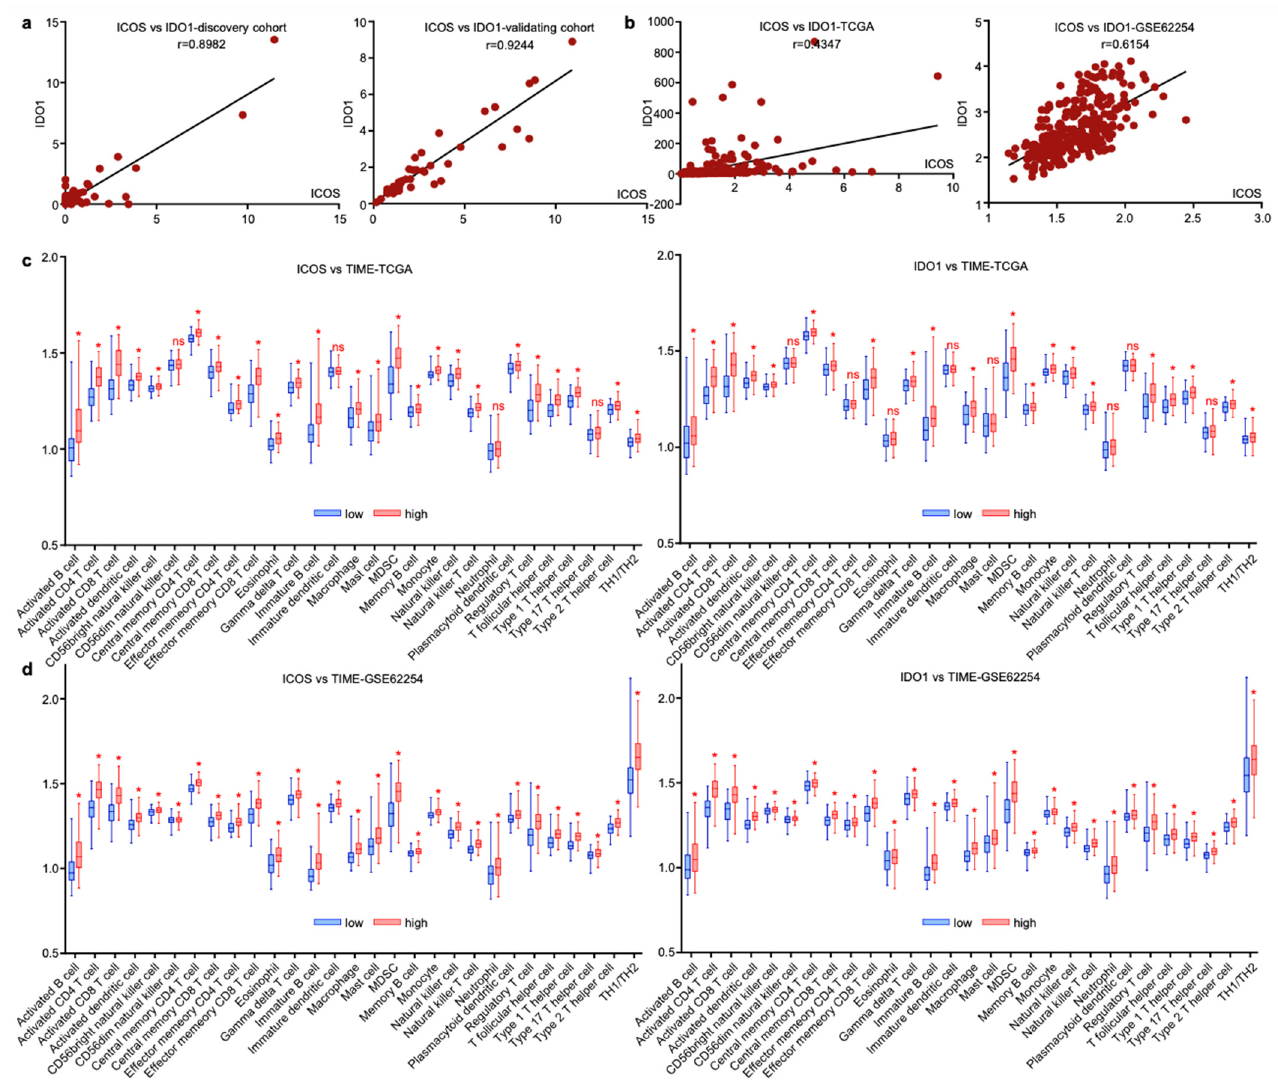
Figure 7. ICOS and IDO1 were related with unique tumor-microenvironmental features. ( A , B ) ICOS and IDO1 were positively correlated in our cohort and in TCGA and GSE62254 databases. ( C , D ) Cellular components of tumor immune microenvironment associated with ICOS and IDO1 in TCGA and GSE62254. (* p < 0.05, ns, non-significant).